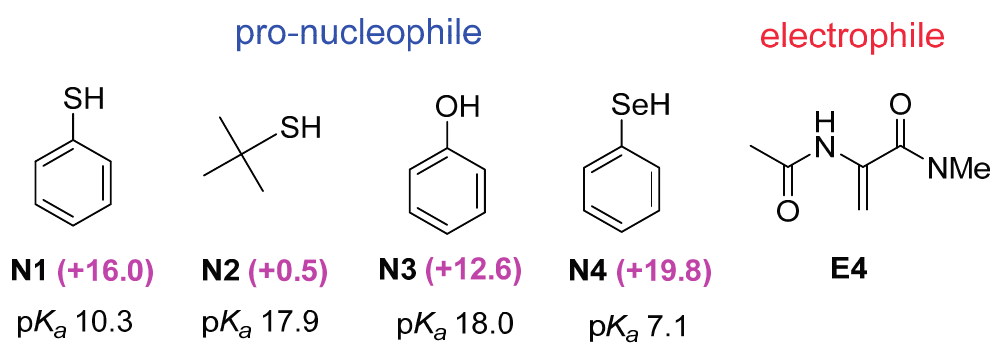
Figure 3. Various pro-nucleophiles ( N1 – N4 ) screened with the optimal electrophile E4 for bicyclic guanidine-catalyzed conjugate addition reactions. ∆∆ G ≠ values (in kJ · mol − 1 ) are given in parenthesis. The p K a values (in DMSO) were taken from Ref. [22]. Comparison of thiophenol ( N1 ) with t -butyl thiol ( N2 ) further confirms this hypothesis. As a